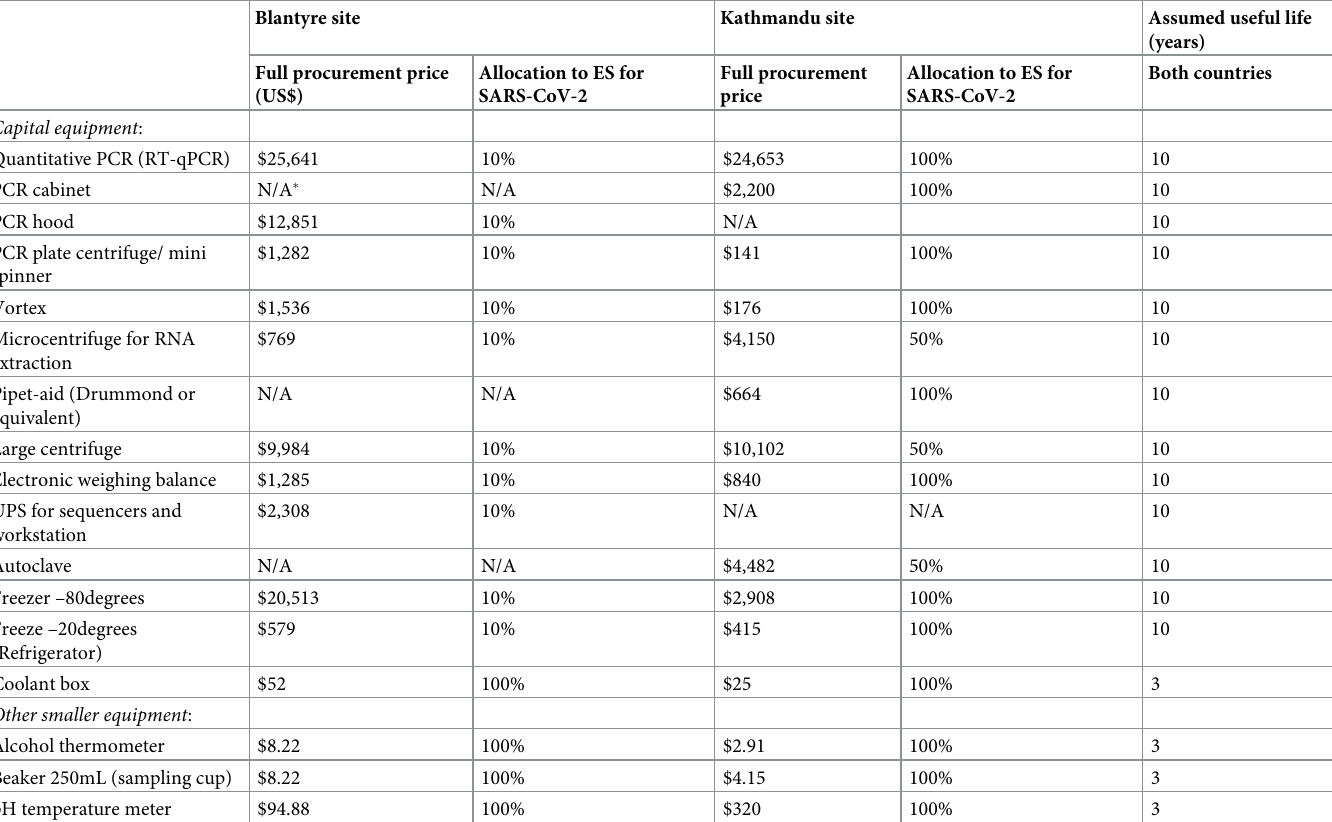
Table 3. Procurement prices for equipment in 2021 US$, allocation to ES for SARS-CoV-2, and assumed useful